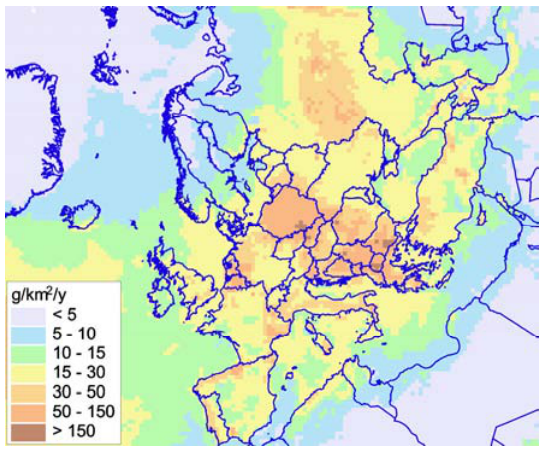
Fig 5. Spatial distribution of cadmium depositions in Europe in 2004